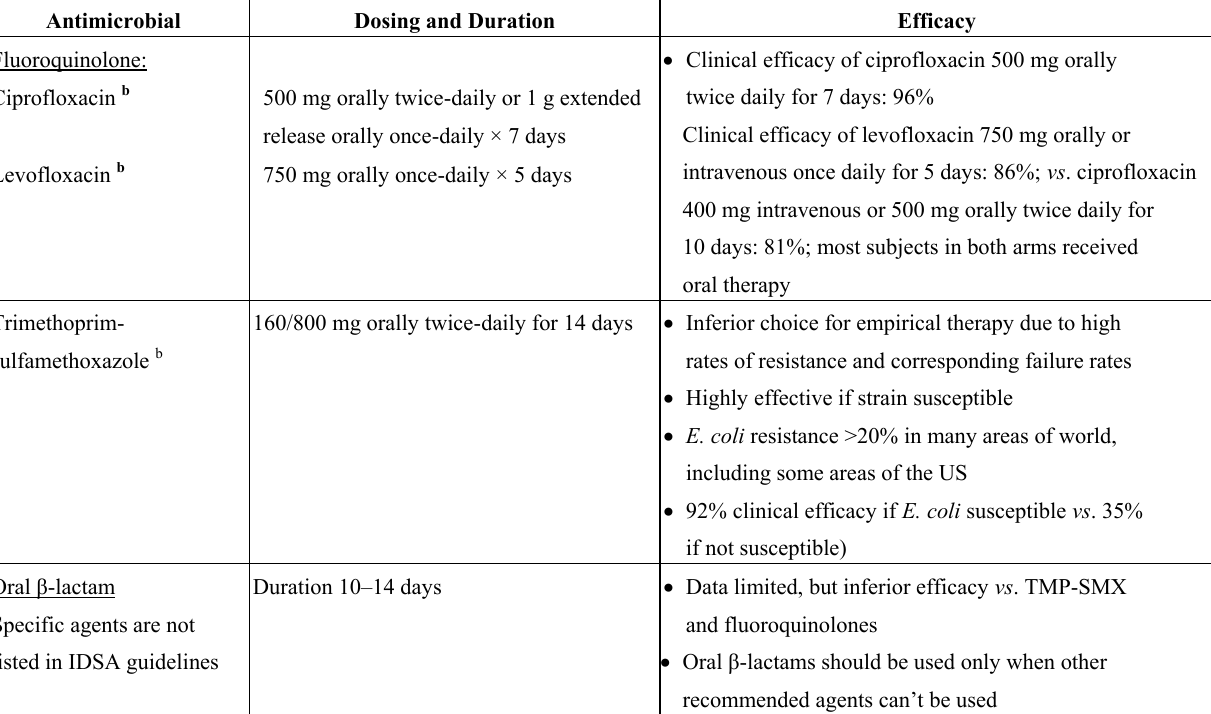
Table 3. Antimicrobial outpatient management of acute uncomplicated pyelonephritis a .